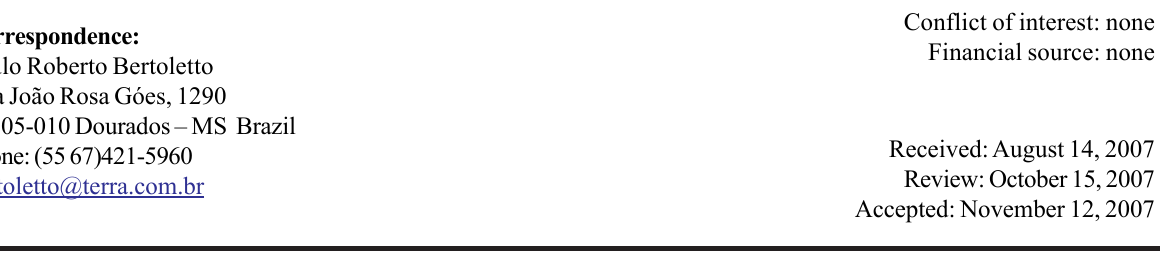
* Color figure available from